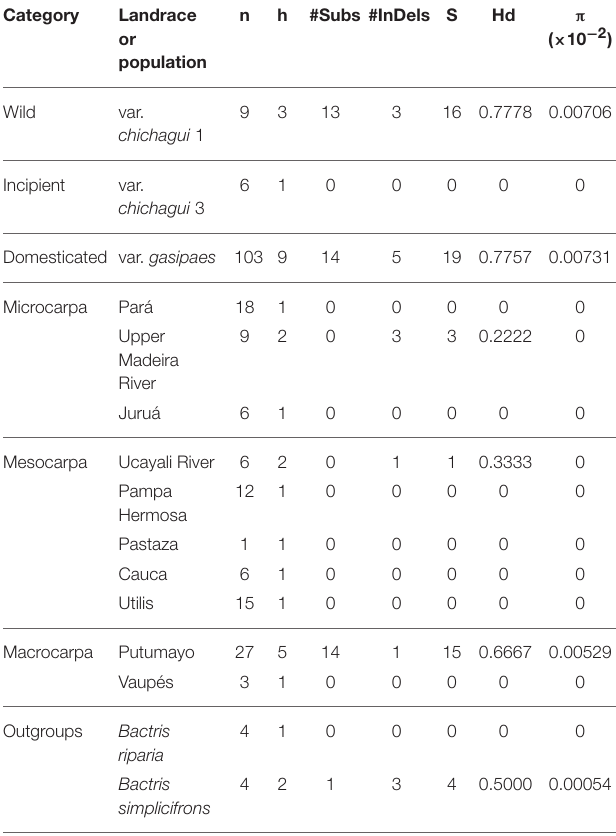
TABLE 2 | Genetic diversity parameters estimated for the two chloroplast sequences for Bactris gasipes var. chichagui types 1 and 3, and seven landraces and two non-designated populations of var. gasipaes in the Core Collection of the Peach palm Active Germplasm Bank, Manaus, Brazil, and two Bactris species used as